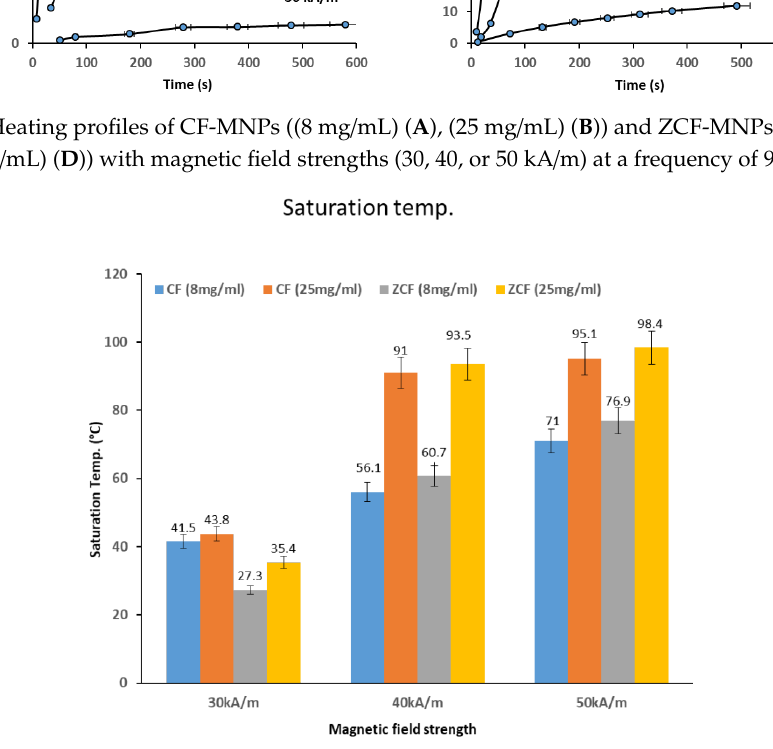
Figure 8. Saturation temperatures of CF-MNPs and ZCF-MNPs by concentration (8 or 25 mg/mL) and magnetic field strengths (30, 40, or 50 kA/m).